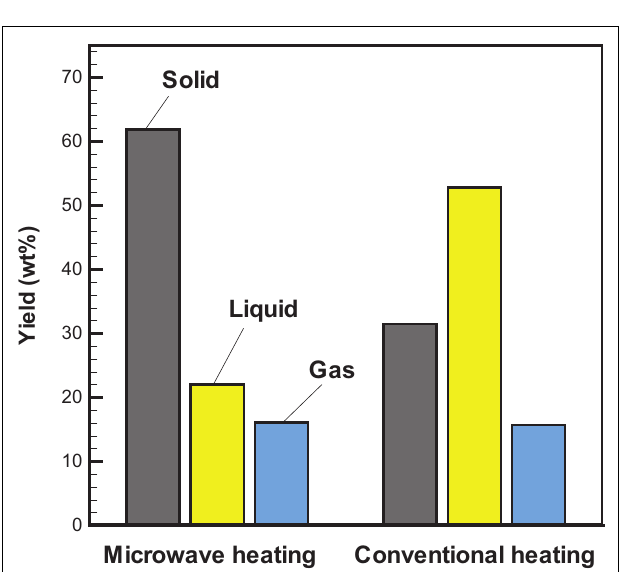
FIGURE 9 | Profiles of product yields from bagasse pyrolysis under conventional and microwave-assisted heating at 550°C and the absorber blending ratio of 0.1